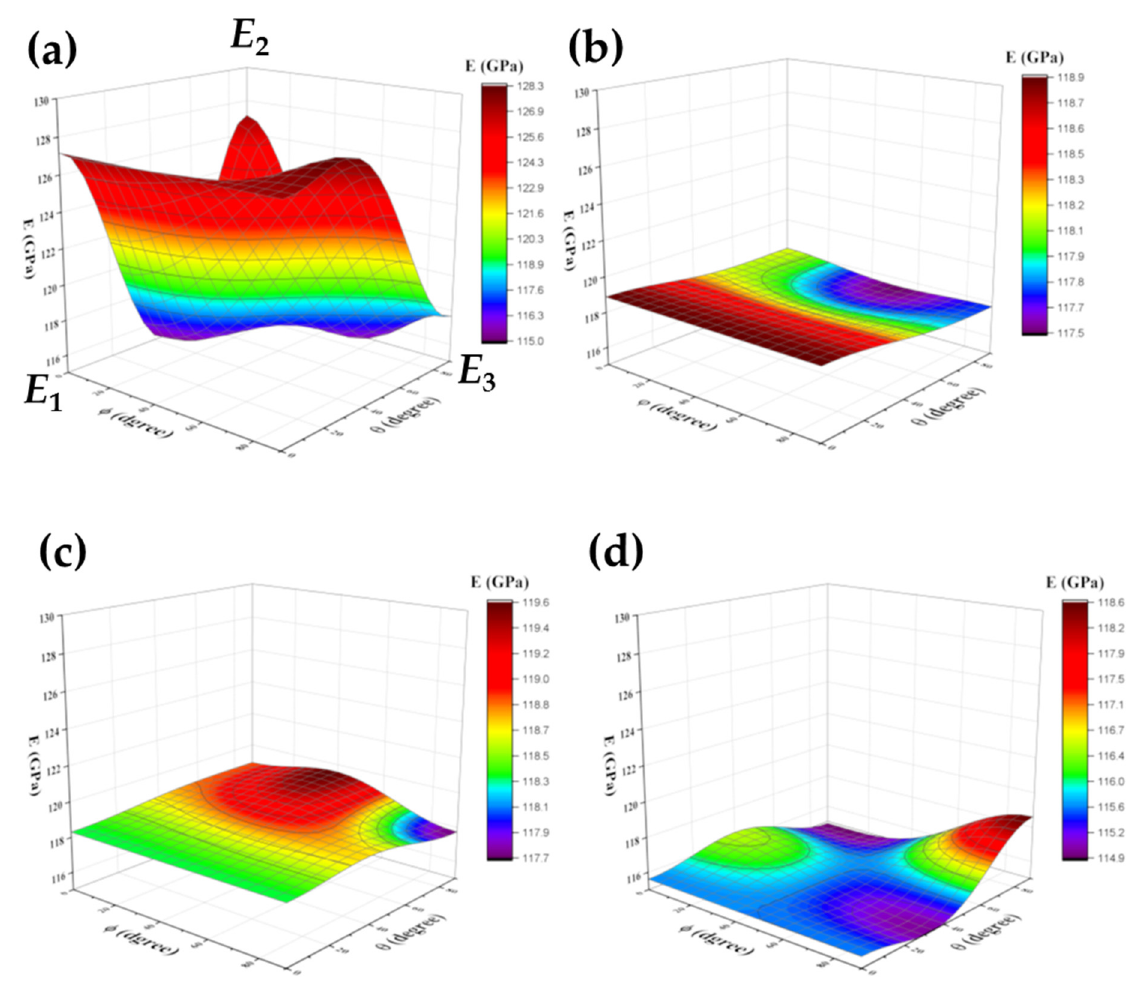
Figure 6. The 3D young’s modulus maps of Ti6Al4V samples fabricated by various methods: ( a ) commercial rod sample, ( b ) DED, ( c ) EBM, ( d ) SLM.